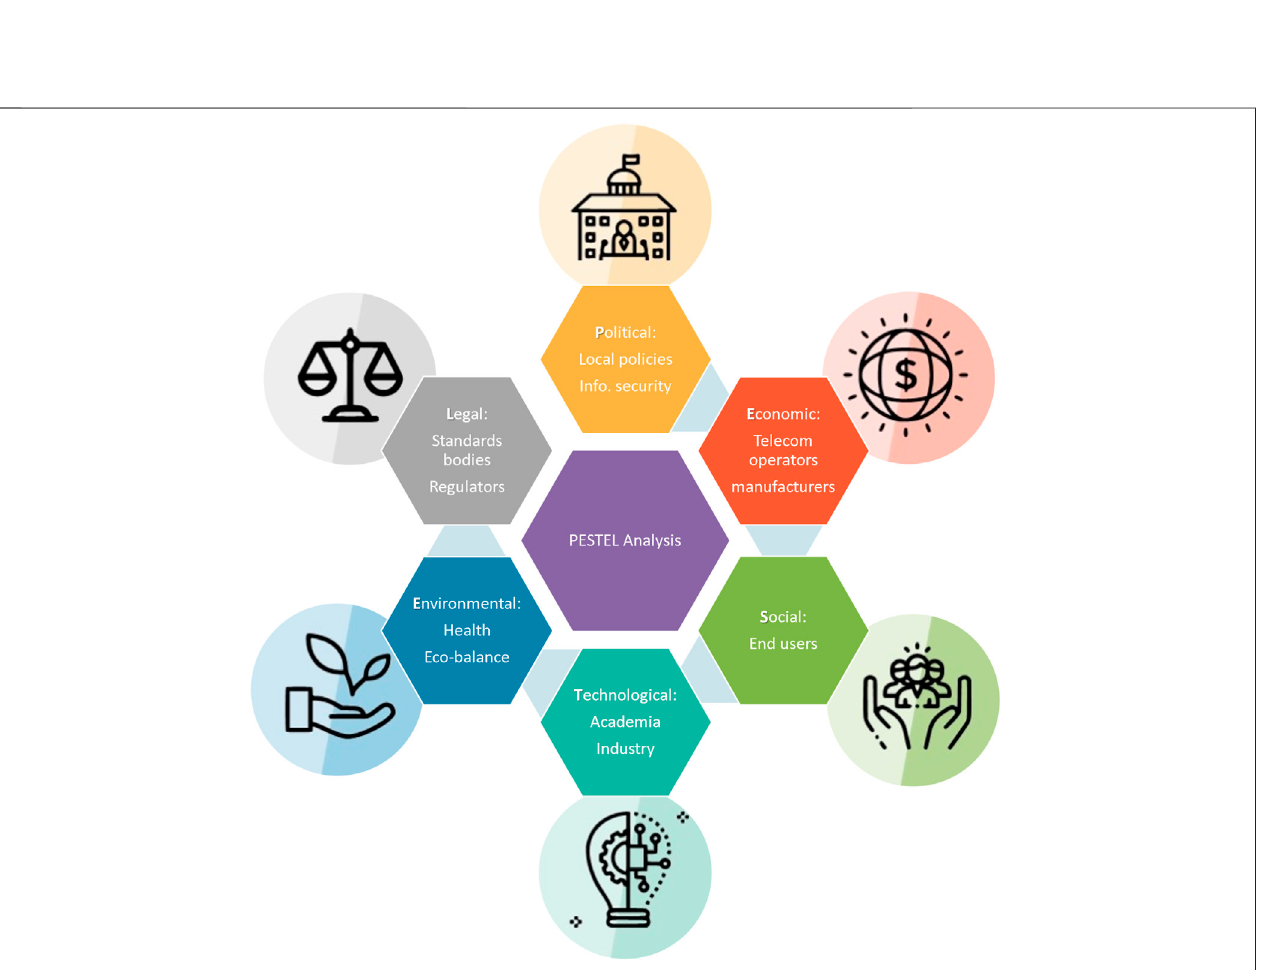
FIGURE 1 | PESTEL framework for analyzing the failure of Project